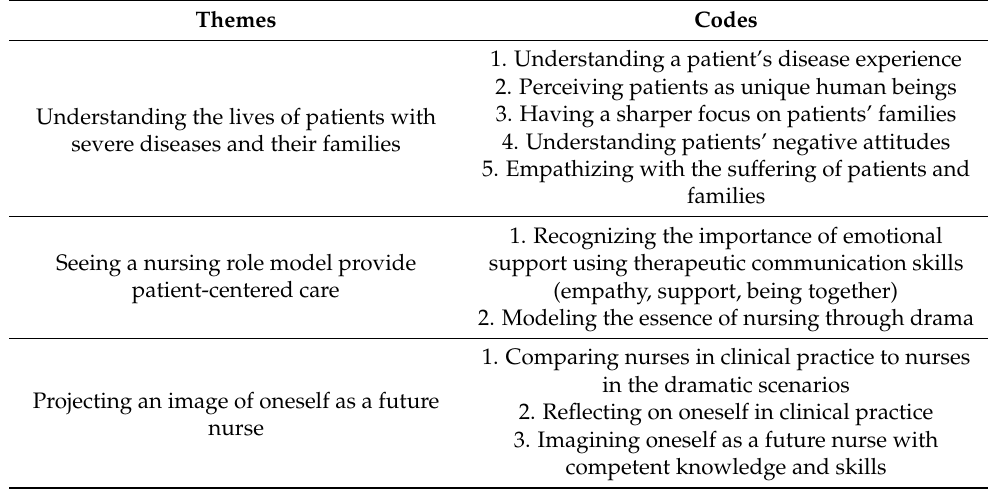
Table 2. Themes and codes from students’ experiences of drama-combined